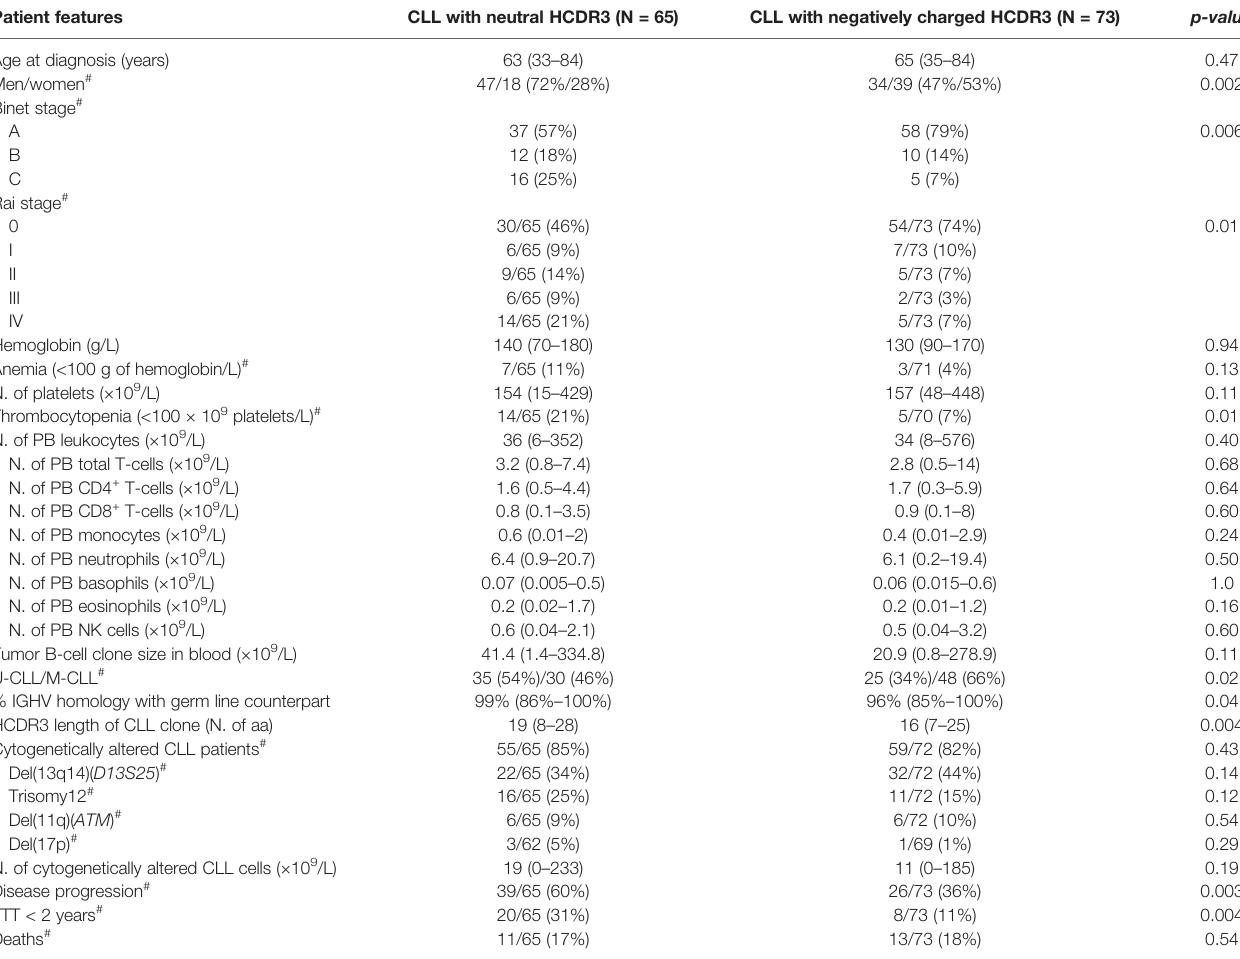
TABLE 1 | Clinical and biological features of CLL patients classi fi ed according to the HCDR3 hydropathy index. Patient